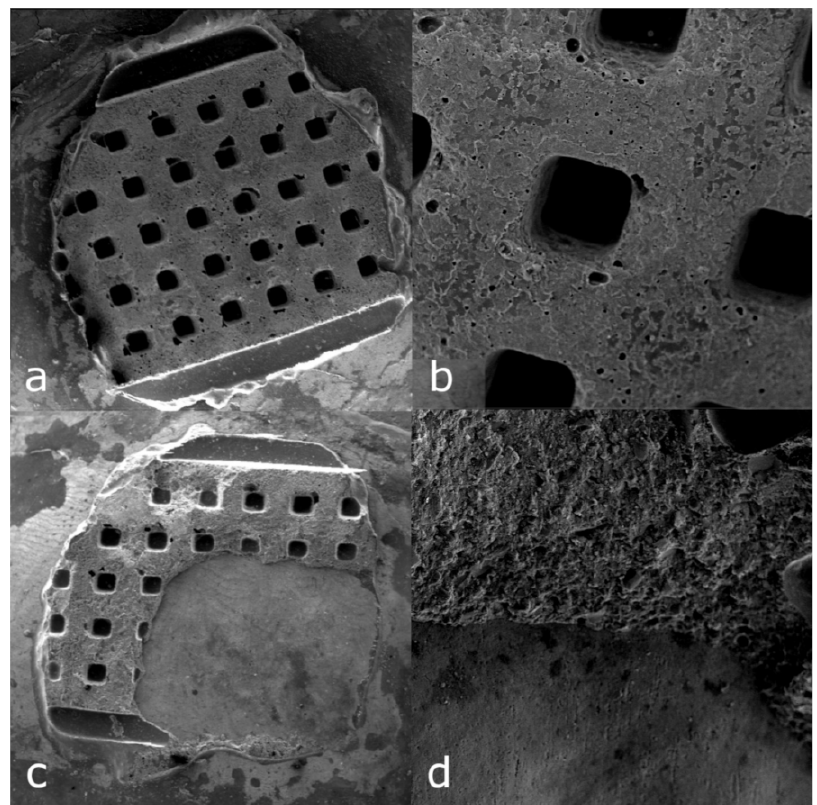
Figure 3. Comparison of the surface of the adhesive remaining on the enamel after Cannon bracket removal with LODI (( a ) 15 × magnification ( b ) 100 × magnification) and with debonding pliers (( c ) 15 × magnification ( d ) 100 ×